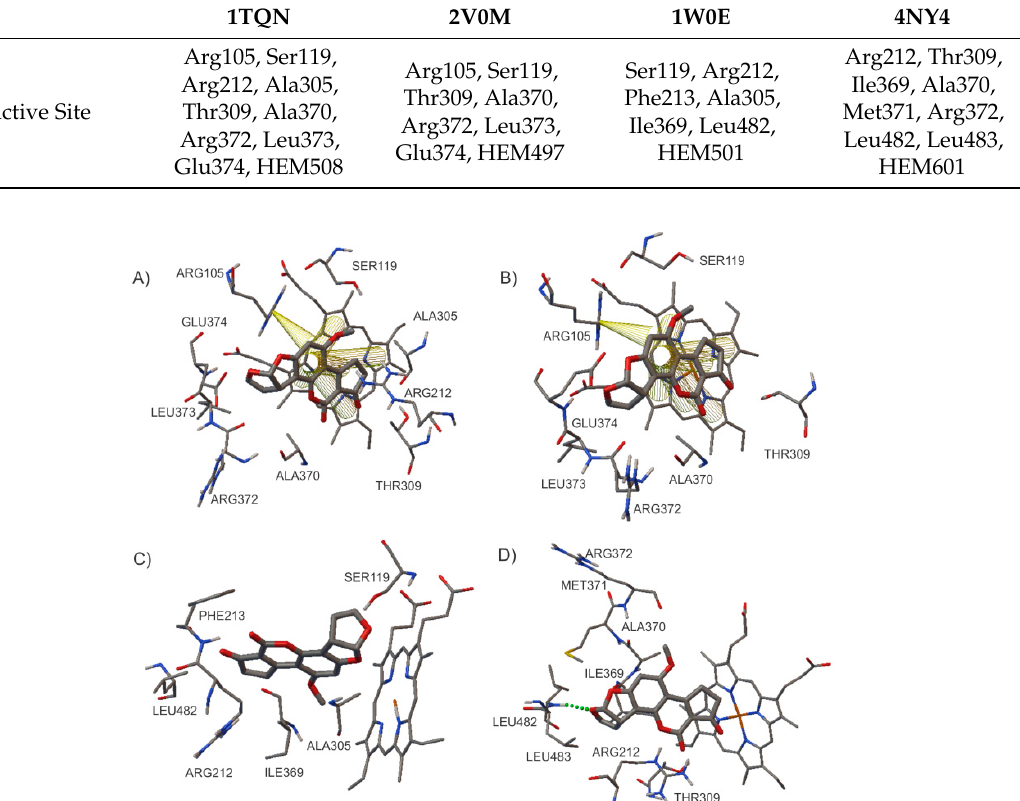
Figure 5. Analysis of the molecular interactions between aflatoxin AFB1 and CYP3A4 (using di ff erent PDB ID files): ( A ) 1TQN, ( B ) 2V0M, ( C ) 1W0E, and ( D ) 4NY4. π – π interactions are indicated as yellow tubes and hydrogen bonds are indicated with green dotted